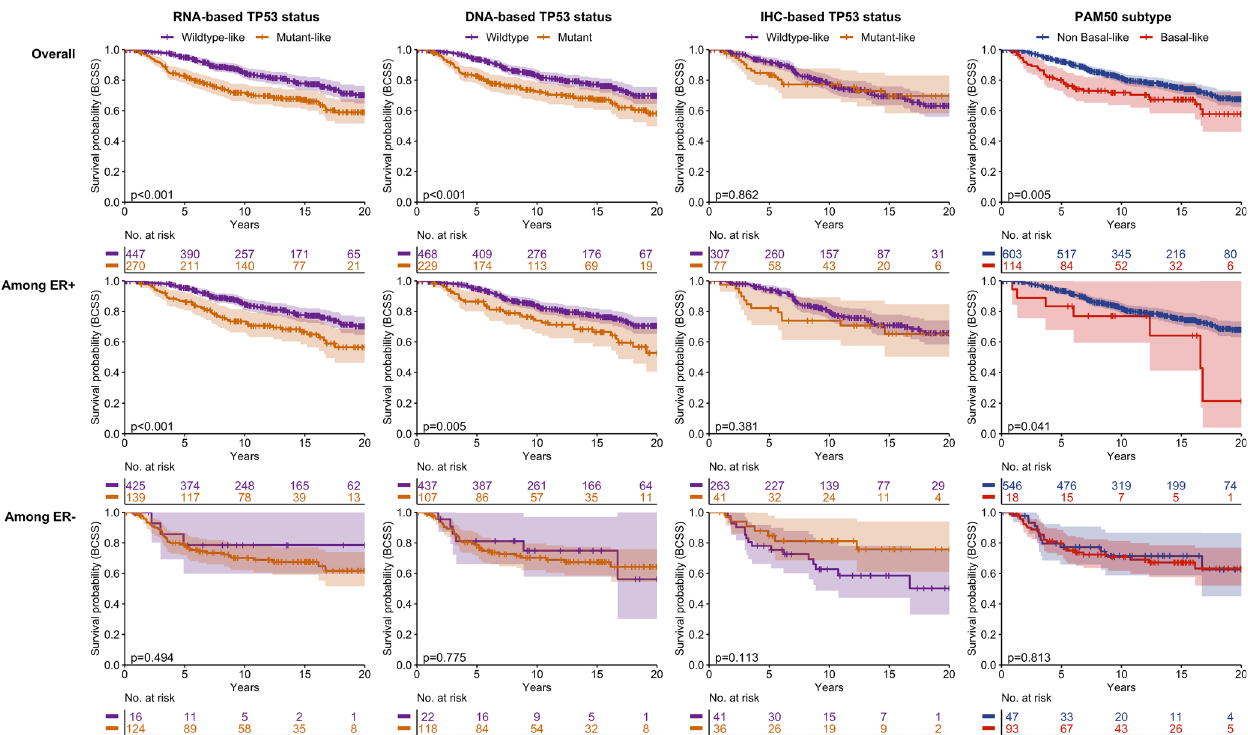
Fig. 2 Kaplan-Meier survival curves for breast cancer-speci fi c survival by tumor subtype, overall and strati fi ed by ER status, among node negative breast cancer cases in METABRIC. p values correspond to the log-rank test. The shaded regions correspond to the 95% con fi dence interval. BCSS = breast cancer-speci fi c survival, ER = estrogen receptor, IHC = immunohistochemistry, METABRIC = Molecular Taxonomy of Breast Cancer International Consortium, PAM50 = Prediction Analysis of Microarray